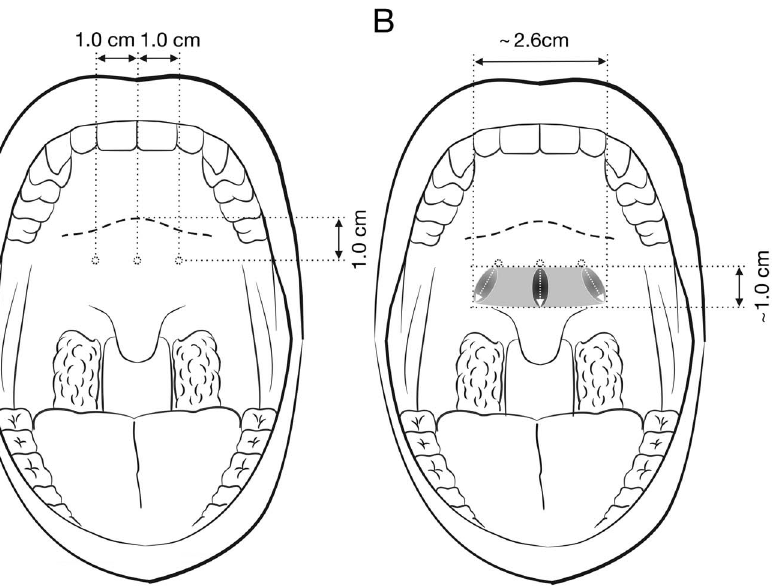
Figure 4. Radiofrequency surgery. (A) Preoperative frontal view illustrating the 3 operative sites of the soft palate (1.0 cm below the hard palate- soft palate junction; 1.0 cm between the midline and para-midline sites). (B) Postoperative frontal view demonstrating the stiffened zone (grey zone) by the RF energy (1.0 cm 6 2.6 cm).